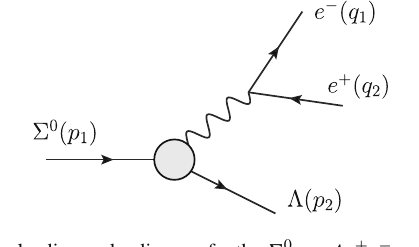
Fig. 1 Theleading-orderdiagramforthe Σ 0 → Λ e + e − processinthe QED expansion. The shaded blob corresponds to the Σ 0 Λγ transition form